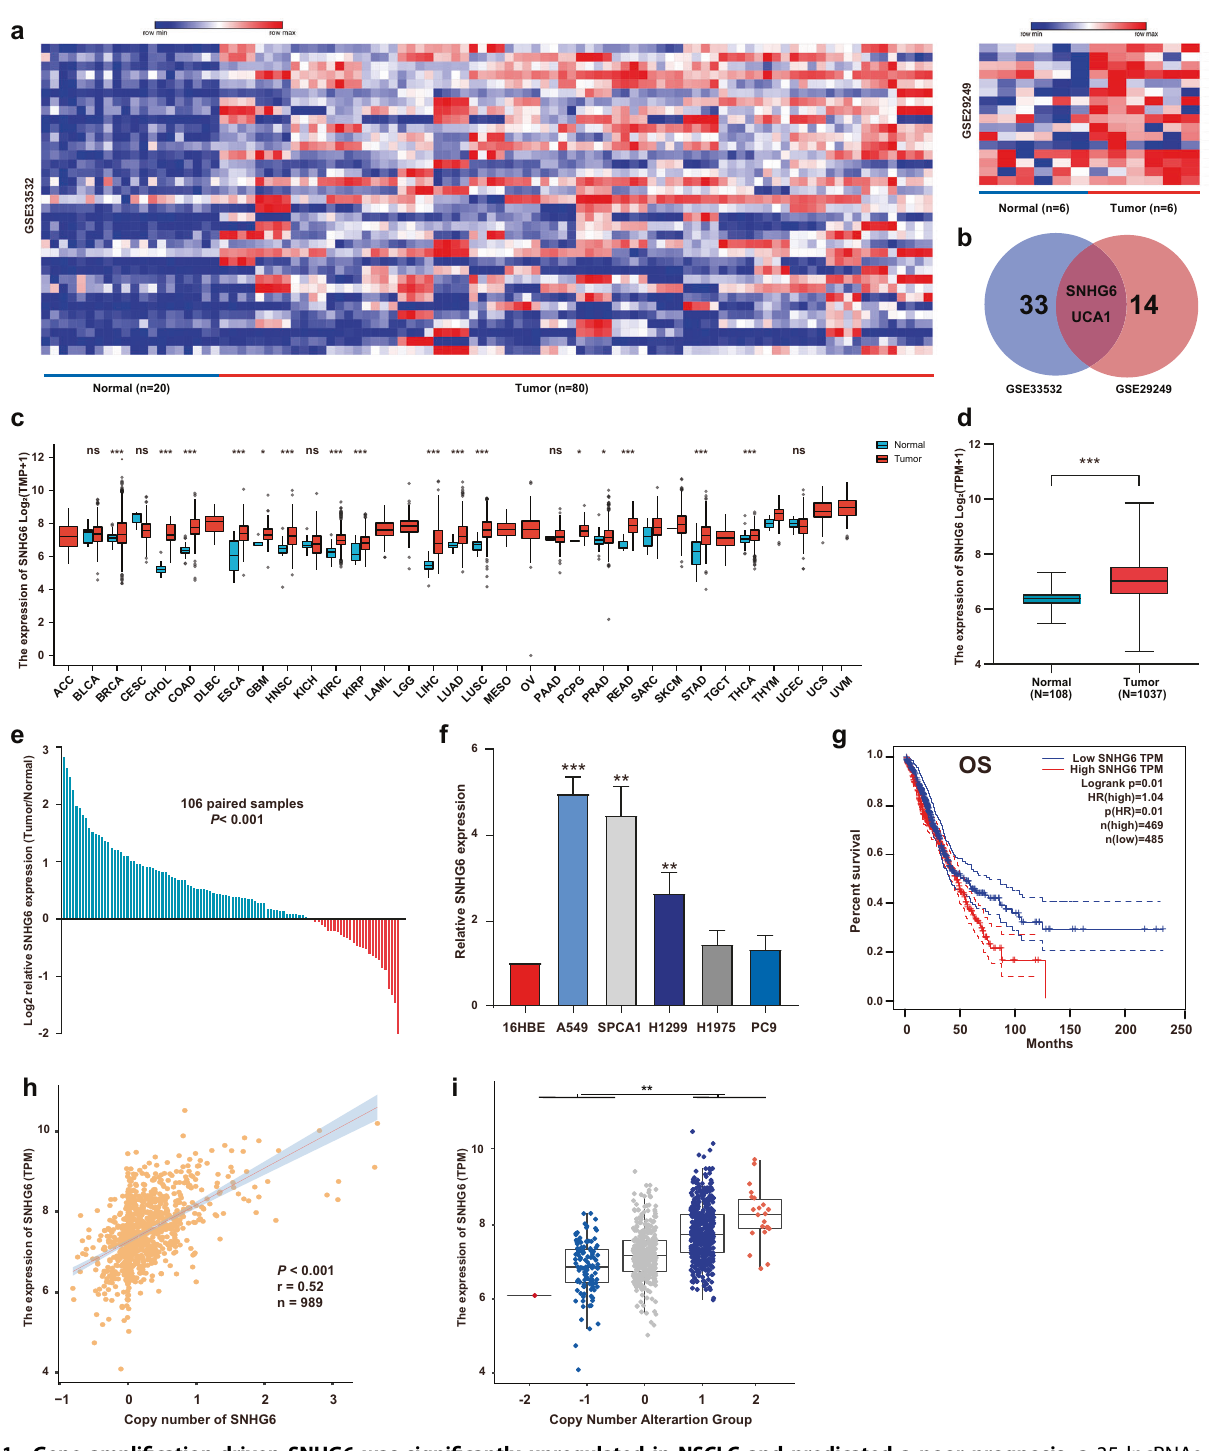
Fig. 1 Gene ampli fi cation-driven SNHG6 was signi fi cantly upregulated in NSCLC and predicated a poor prognosis. a 35 lncRNAs were found upregulated in NSCLC tumor tissues from GSE33532 (20 normals vs 80 tumors) and 16 lncRNAs were found upregulated in NSCLC tumor tissues from GSE29249 (6 normals vs 6 tumors); b UCA1 and SNHG6 were identi fi ed in both datasets; c SNHG6 was upregulated in numerous malignant tumors in the TCGA database; d SNHG6 was upregulated in NSCLC tumor tissues compared with normal tissues in unpaired samples (Normal = 108, Tumor = 1037); e The differential expression level of SNHG6 in 106 paired samples (paired student ’ s t -test); f SNHG6 was upregulated in NSCLC cell lines (A549, SPCA1, and H1299) compared with 16HBE (unpaired student ’ s t -test); g High expression of SNHG6 was associated with a poor prognosis (OS, overall survival, log-rank test); h SNHG6 expression was positively related to the copy number of SNHG6 in NSCLC ( P < 0.001, r = 0.52, n = 989); i SNHG6 expression in different copy number alteration group. Variables were presented as the mean ± SD (Standard deviation). *** P < 0.001, ** P <